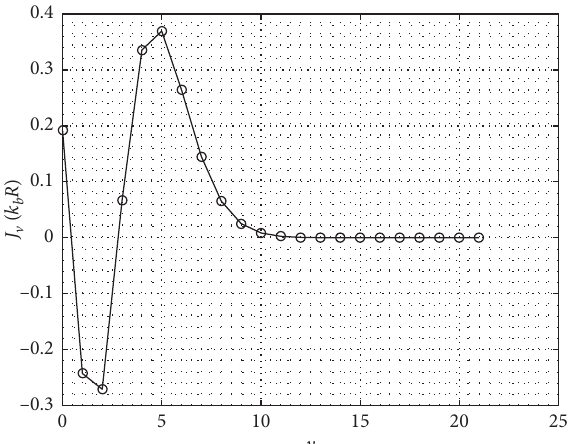
Figure 2: Bessel function behaviour versus the order v .